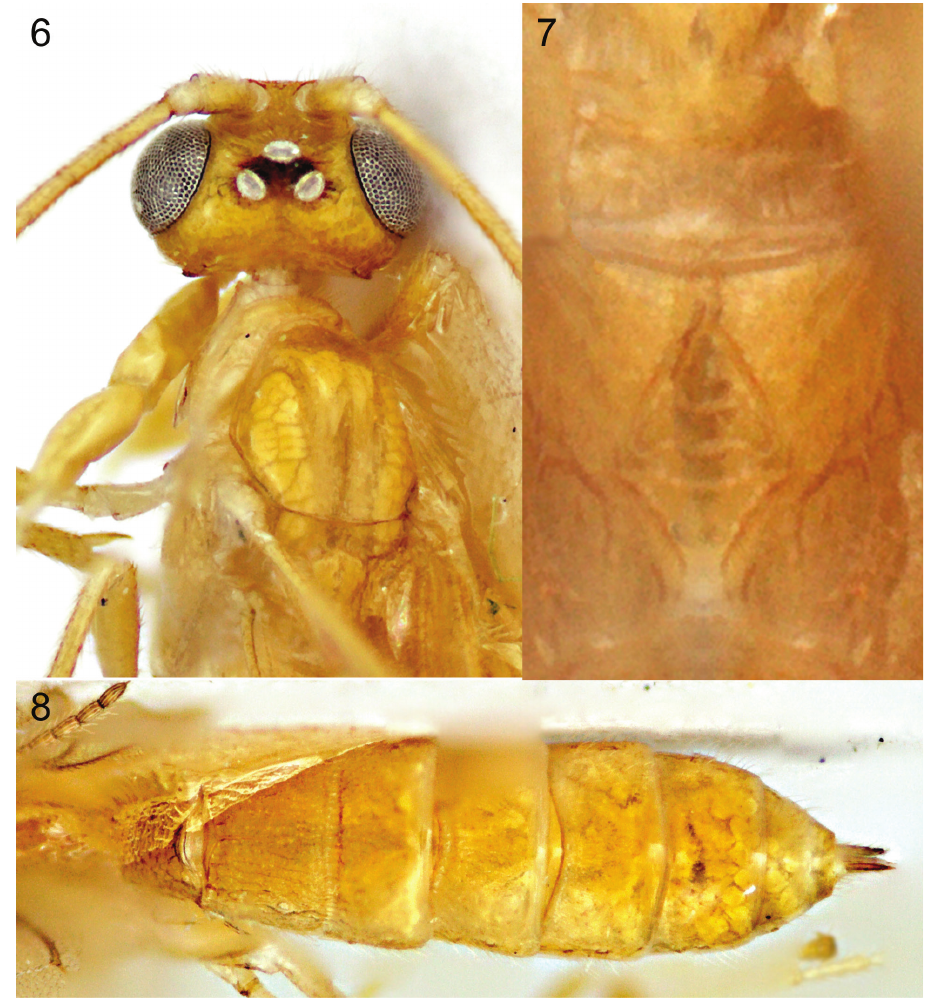
Figures 6–8. Colastomion gregarius sp. n. light photomicrographs. 6 Head and anterior mesosoma, dor- sal view 7 propodeum 8